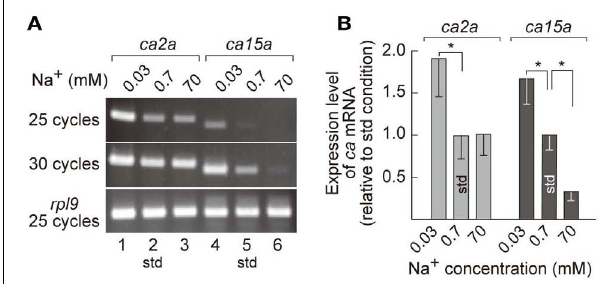
FIGURE 3 | Salinity-dependent expression of ca2a and ca15a in zebrafish larvae. (A) Expression level of ca2a and ca15a in different salinity medium was analyzed by RT-PCR with RNA extracted from 7-dpf larvae reared in 0.0003% (0.03mM Na + ), 0.006% (0.7mM Na + ), or 0.6% (70mM Na + ) salt water. rpl9 (ribosomal protein L9 mRNA) was used as expression control. (B) Levels of ca2a and ca15a mRNA expression estimated by quantitative RT-PCR (qPCR) ( n = 4). Data are expressed relative to the value obtained under the standard culture conditions (std; 0.7mM Na + ). * p < 0.05 in the comparison with the standard culture condition (Student’s t -test).